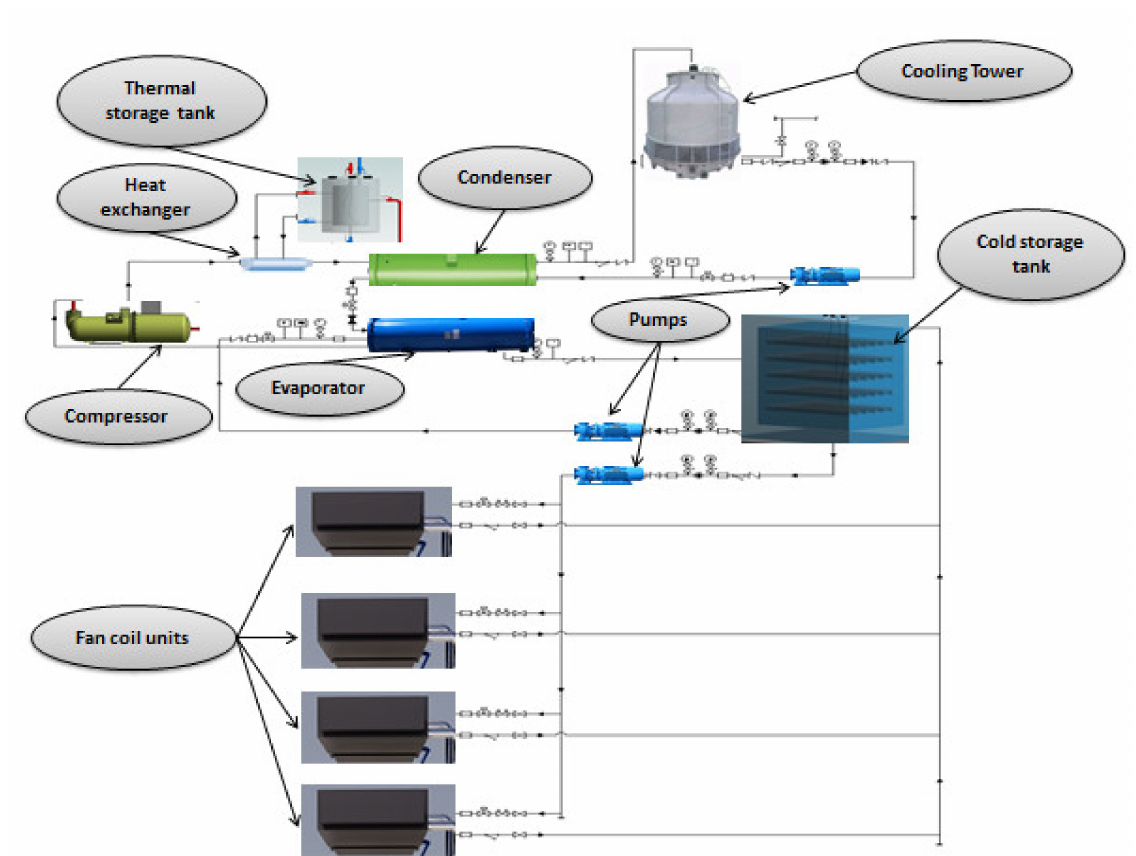
Figure 8. Schematic of the water chiller air-conditioning system combined with both cold and thermal